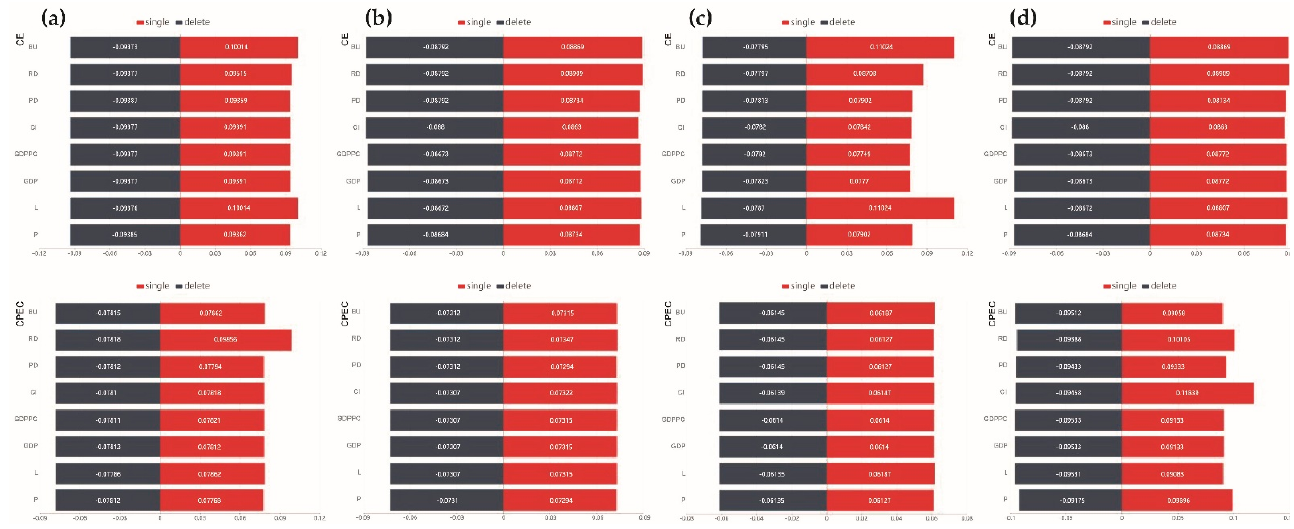
Figure 6. The influence of various factors on the CE and CEPC in regression analysis results using XGBoost. ( a ) Beijing; ( b ) Tianjin; ( c ) Shanghai; ( d ) Chongqing. XGBoost. ( a ) Beijing; ( b ) Tianjin; ( c ) Shanghai; ( d )